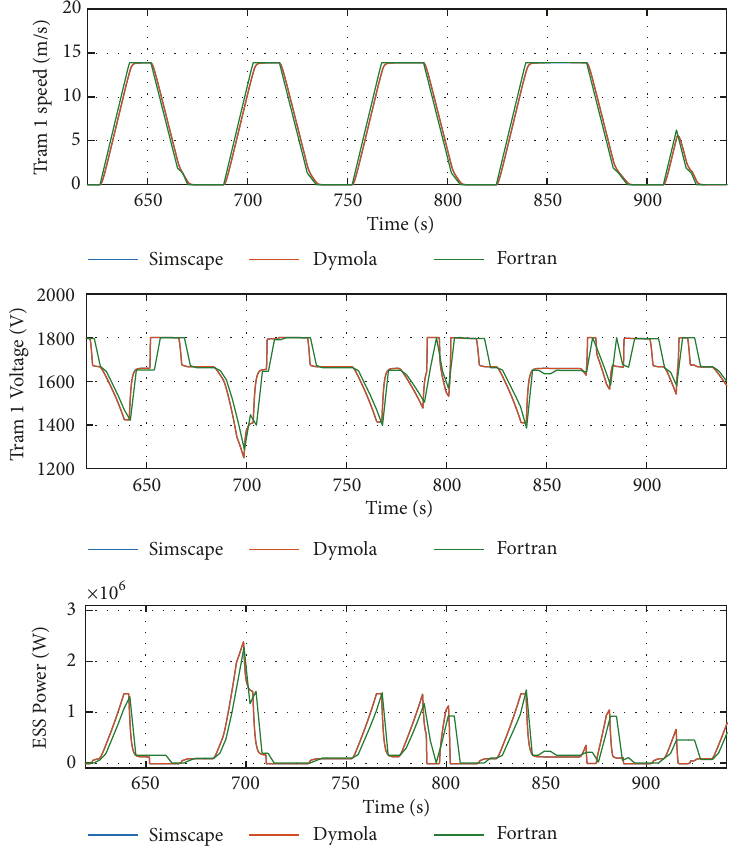
Figure 6: Plot results, trams with braking energy recovery.